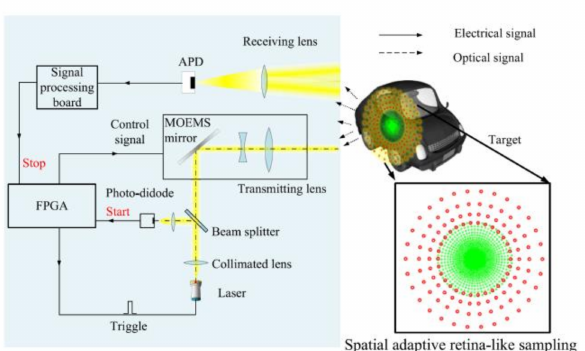
Figure 4. Retina-like LiDAR based on